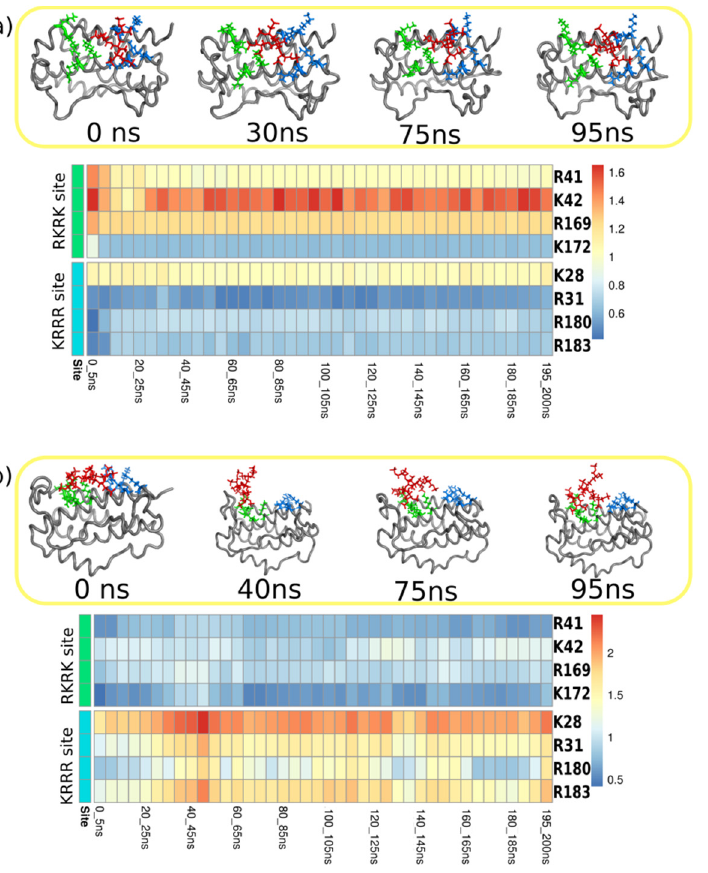
Figure 5. Analysis of the MD simulations for two docked poses into RKRK&KRRR box: ( a ) dPGS of the first generation; and ( b ) dPGS of the second generation. Upper parts show snapshots from the MD, with IL6 colored grey, dPGS colored red, amino acids from RKRK site are green and amino acids from KRRR skyblue. Heat maps present analysis of the distances between central C3 atom of the dPGS and positively charged amino acids from RKRK (R41, K42, R169, K172) and KRRR (K28, R31, R180, R183) site during 200-ns MD. Heat map represents distances from 0.4 to 1.6 nm where blue color indicated shorter distances and red longer. This means that dPGS remains close to its initial position near the KRRR group of amino acids in the case of the first generation dPGS. The second generation dPGS remains close to the RKRK site amino acids.